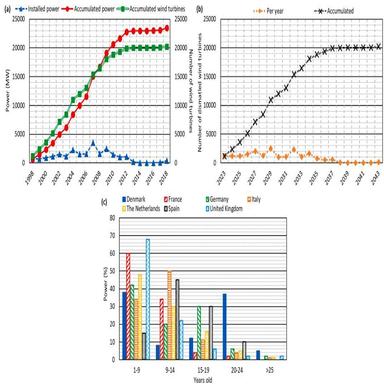
Situation of the wind-energy sector (: (a) evolution of wind-energy sector in Spain over recent years; (b) number of wind turbines to be dismantled in Spain over forthcoming years; (c) age of wind turbines within the main European wind-power-generating countries.